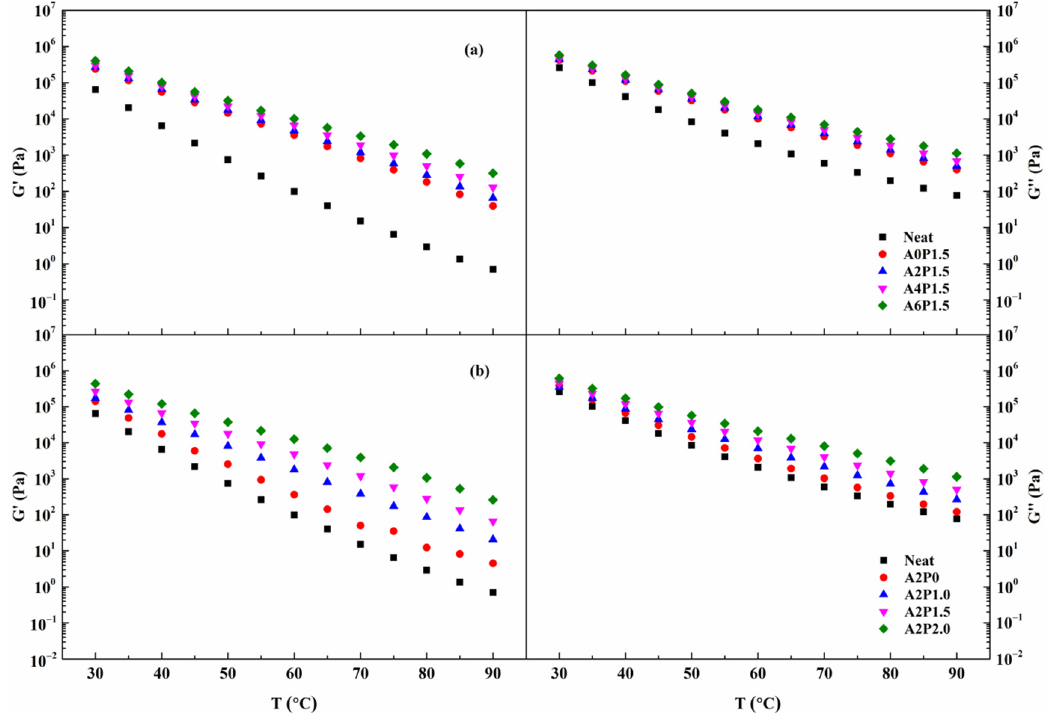
Figure 7. G ′ and G ″ variations with temperature for composite modified binders: ( a ) composite modified binders with various contents of APAO; ( b ) composite modified binders with various contents of PPA.